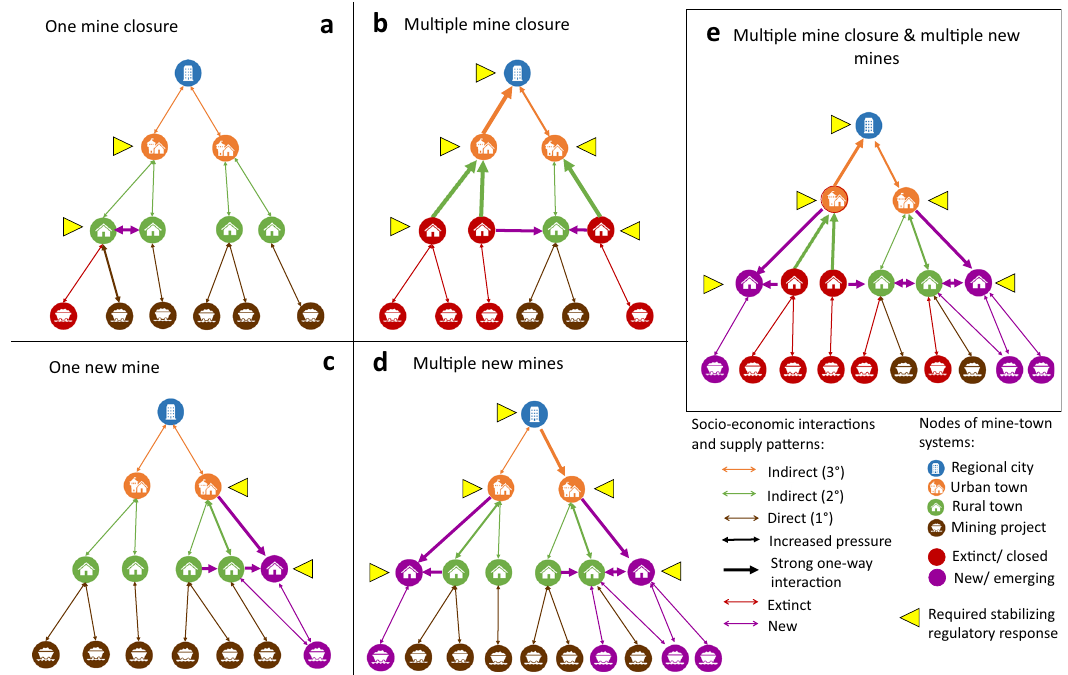
Fig. 2 | Impacts of mine closure and mine opening suggested across the mine- town systems. a A closure of a single project has a direct impact on an associated rural town, which leads to increased pressure on other rural towns in the system. Overexpansionofaruraltownrequiresastabilisingregulatoryresponseattherural and urban towns levels. b Multiple mine closures drive out-migration from asso- ciated rural towns to urban towns, putting pressure on new host locations. A sta-